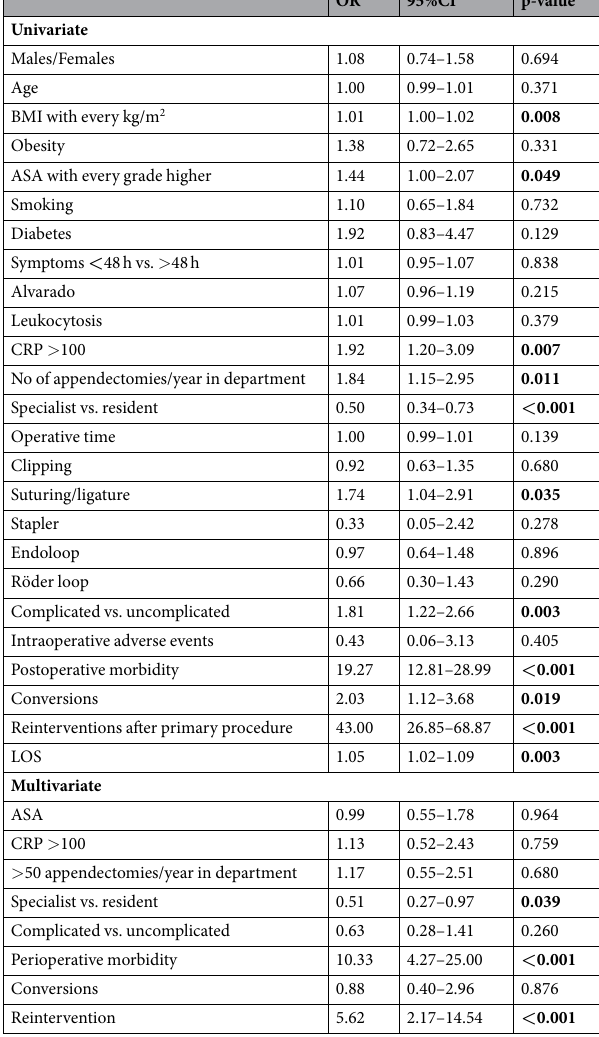
Table 4. Risk factors for hospital